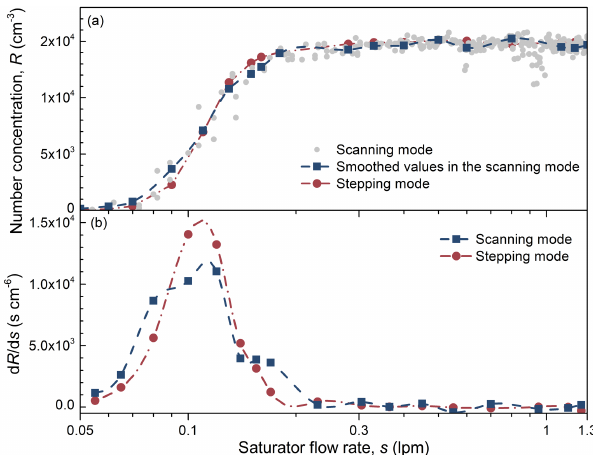
Figure 13. (a) The relationship between the recorded particle num- ber concentration and the saturator flow rate in the scanning mode and the stepping mode. (b) The derivative of number concentration with the respect to the saturator flow